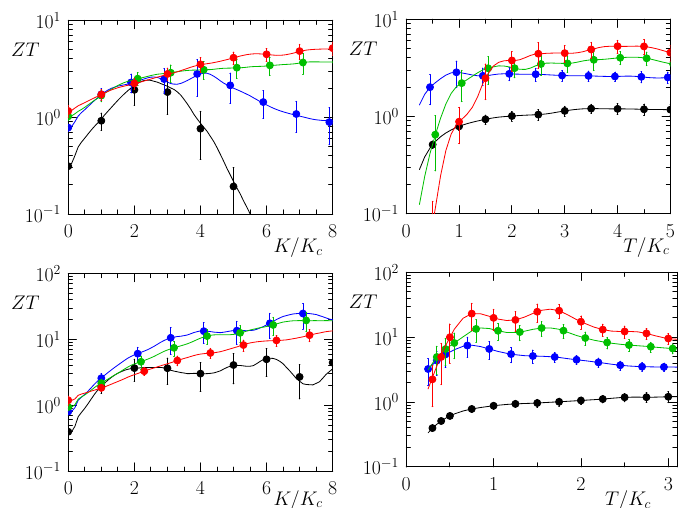
Figure A4. Dependence of ZT on the rescaled potential amplitude K / K c ( left column) and on the rescaled temperature T / K c ( right column) for N / L = 34/21 = ν 1.618 ( top row) and N / L = ≈ 55/21 = ν 2.618 ( bottom row). Left : color curves show the cases T / K c = 0.5,1,2,3,4 for N / L = ≈ 34/21 and T / K c = 0.3,0.8,1.3,1.6,2.3 for N / L = 55/21 (black, violet, blue, green, red from top to bottom curves). Right : K / K c = 0,2,4,6,8 for N / L = 34/21 and N / L = 55/21 (black, violet, blue, green, red from bottom to top curves). Here K c = 0.019 for ν = 34/21 and K c = 0.14 for ν = 55/21.